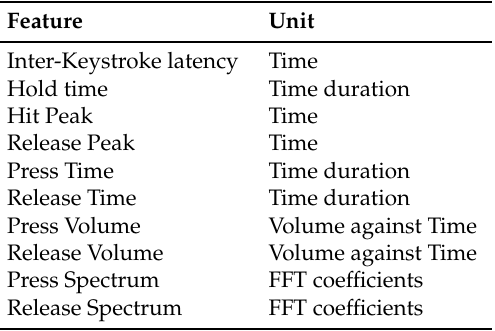
Table 1. Compelling features observed in acoustic